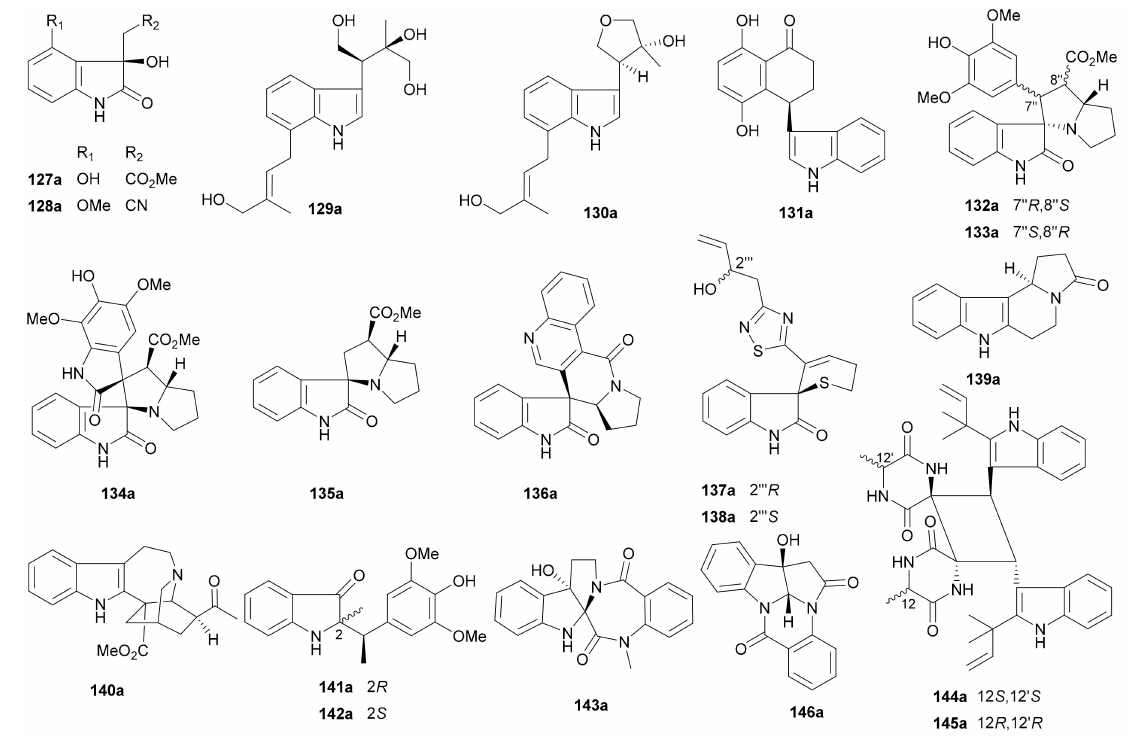
Figure 8. Structures of indole alkaloids. Song and coworkers reported two pairs of oxindole enantiomers 127a / 127b and 128a / 128b from Isatis tinctoria in 2019 [81], while 128b had been previously reported in optically pure form from Isatis indigotica in 2012 [82]. In 2017, Zhang and colleagues discov- ered two pairs of enantiomers bearing two prenyl groups ( 129a / 129b and 130a / 130b )